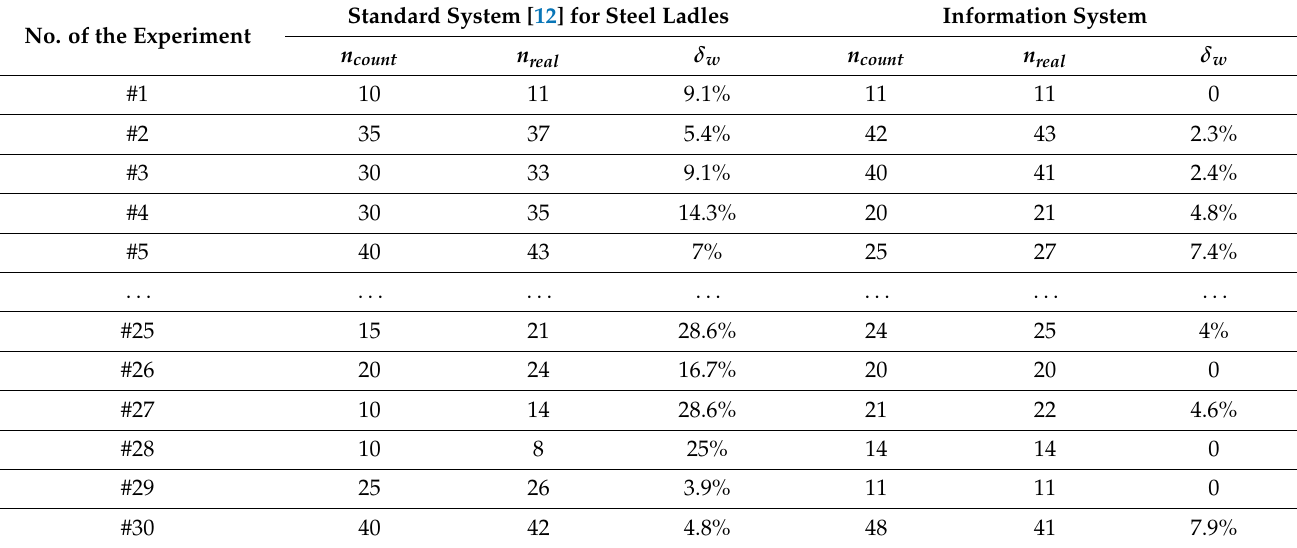
Table 4. Experimental determination of the number of permissible pouring of liquid